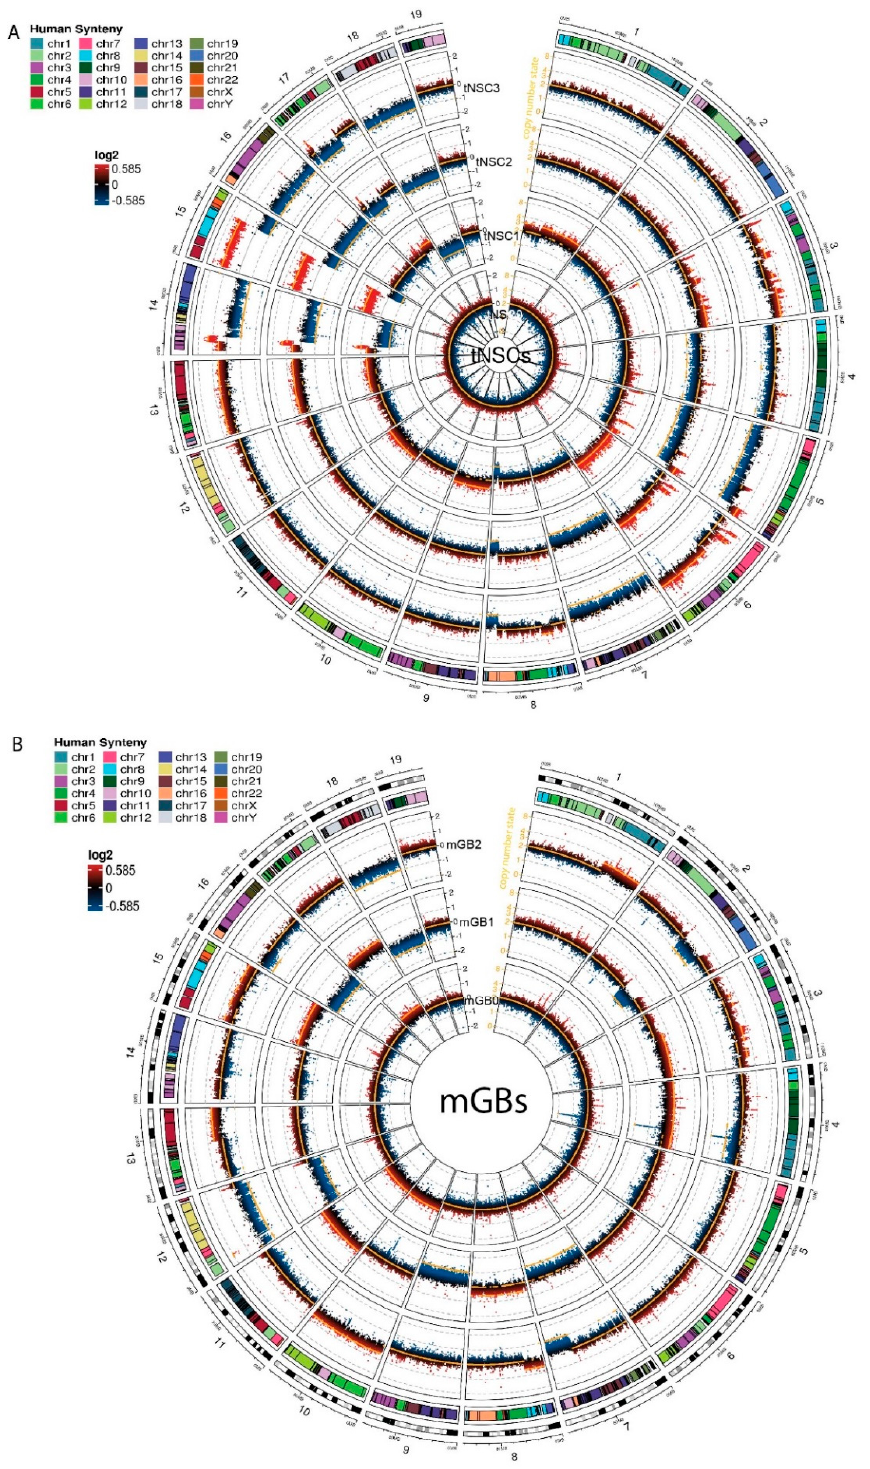
Figure 3. Copy number aberration analysis identifies specific chromosomal aberrations of the new murine glioma cell lines. ( A , B ) Circos plots showing copy number aberrations (CNA) of tNSCs ( A ) and mGBs ( B ) cell lines. CNVkit-calculated log2 ratios for each genomic bin are plotted as colored points (black y-axis scale; red corresponds to increased log2 ratios, and blue to decreased), with the inferred copy number state plotted as an orange line (orange y-axis scale). Each circular sector represents one chromosome. Human syntenic regions are shown at the top of each chromosome.